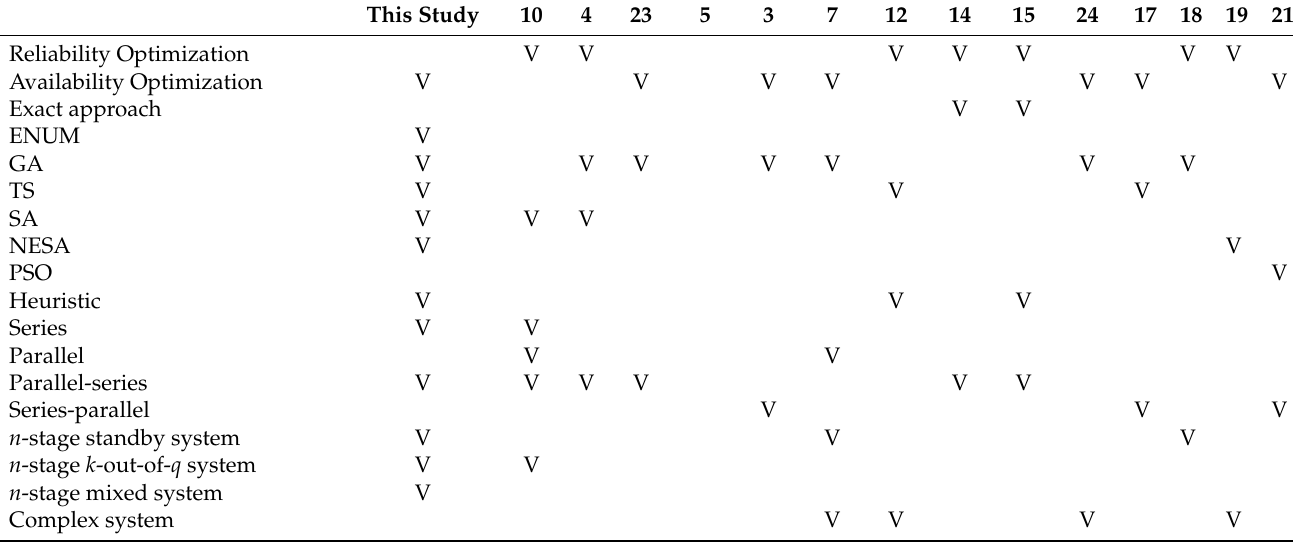
Table 1. The main difference between this study and the above-surveyed literature. This